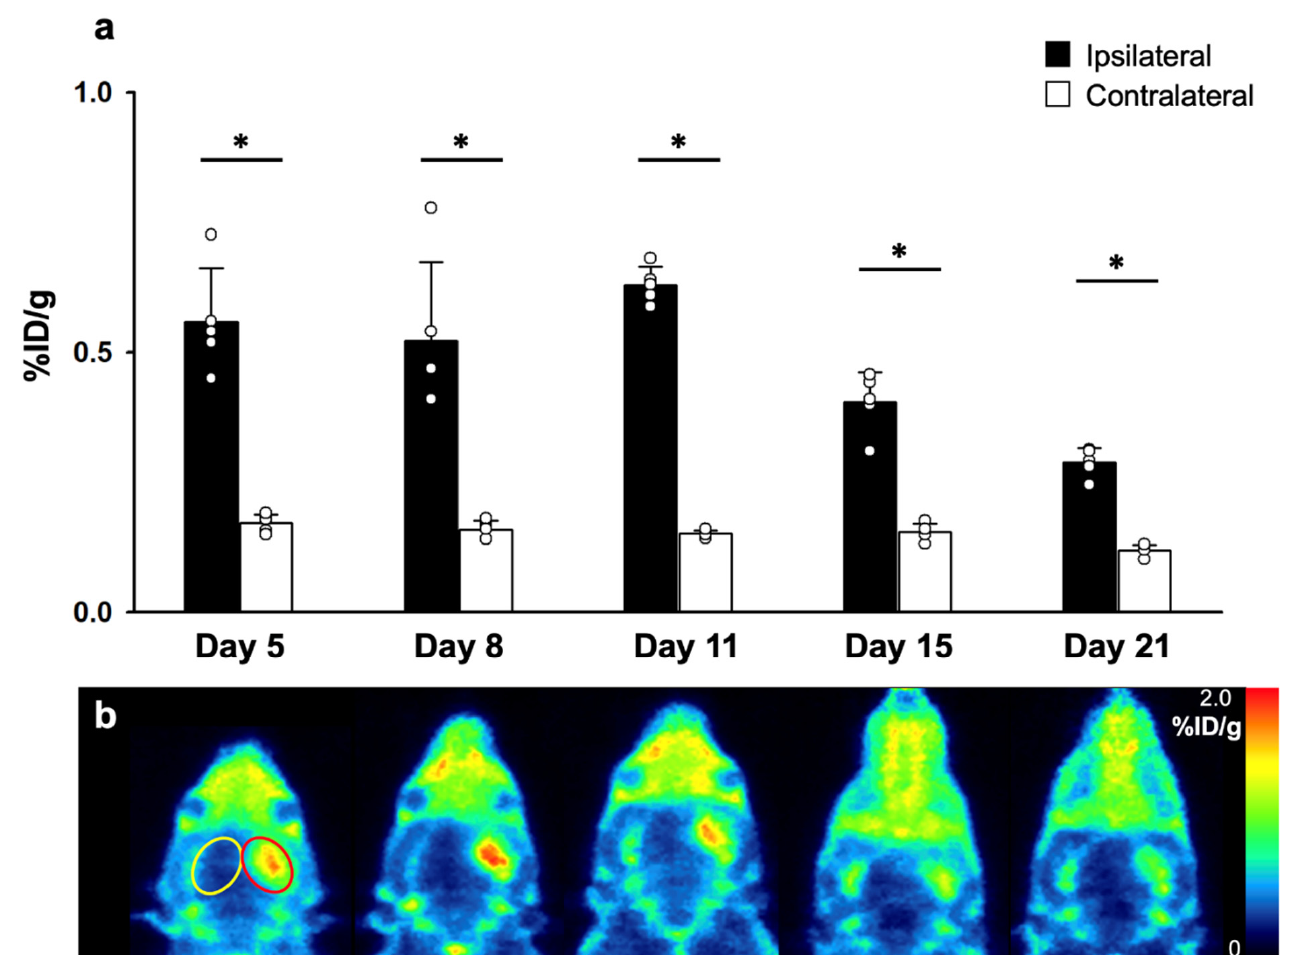
Figure 5. %ID/g values of [ 18 F]fluoromethyl-PBR28- d 2 ( 2 ) on days 5, 8, 11, 15 and 21 after MCAO surgery ( a ). Representative [ 18 F]fluoromethyl-PBR28- d 2 ( 2 ) PET images at respective days ( b ). Red oval indicates the MCAO-lesioned VOI, and yellow oval indicates the contralateral VOI. The statistical significance of differences were determined using the Mann-Whitney U test; * p < 0.05.